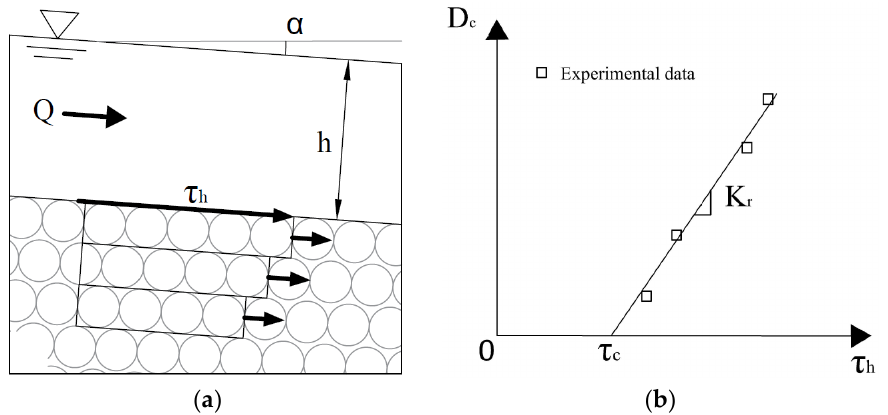
Figure 1. Erosion formation: ( a ) hydraulic conditions; ( b ) erosion function.